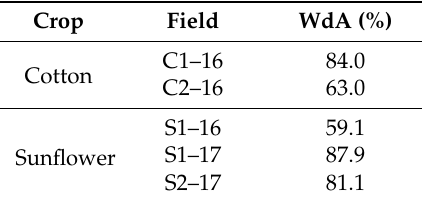
Table 3. Accuracy assessment on weed discrimination based on the Weed detection Accuracy (WdA) index attained for UAV images taken at 30 m flight